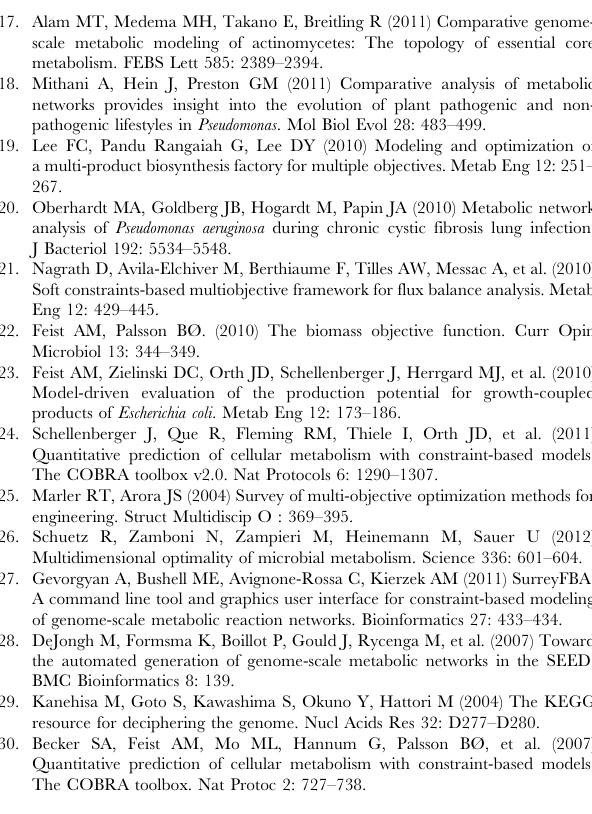
Table S2 Correlation between reaction